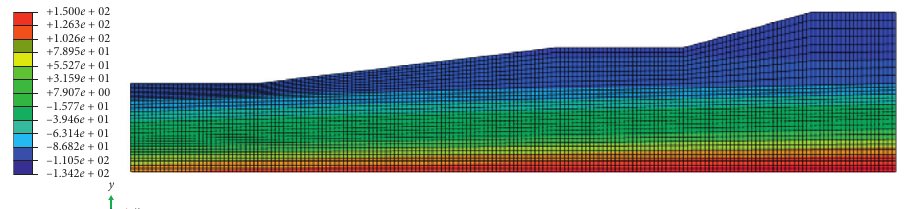
Figure 9: Distribution of pore pressure.